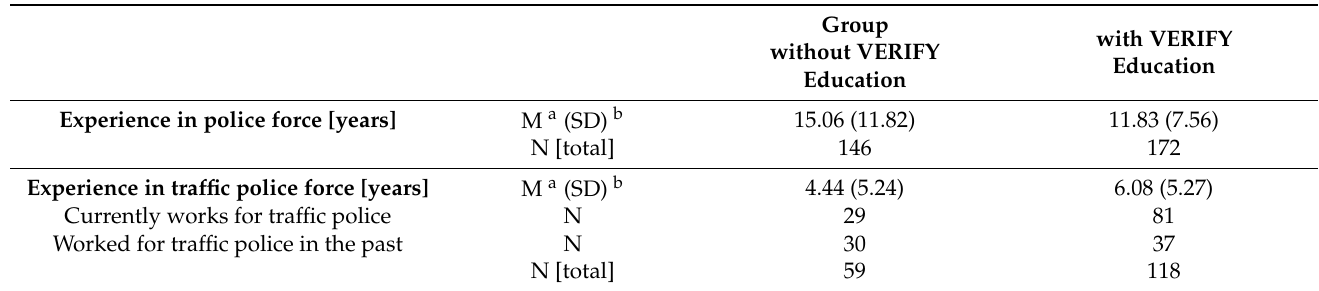
Table 2. Self-reported years of experience of police officers in traffic police or in other police forces for police officers with and without education in the VERIFY procedure.